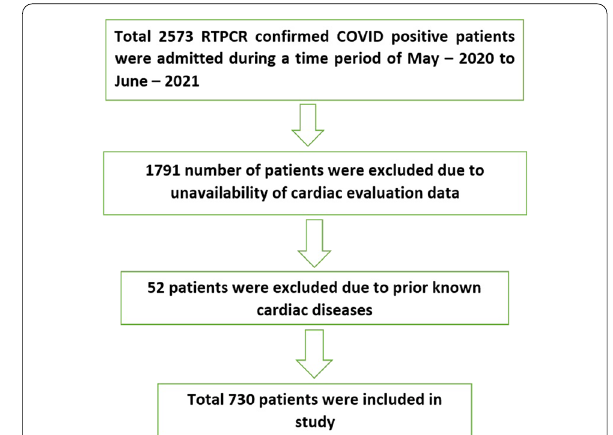
Fig. 1 Flowchart of patient inclusion and exclusion in the